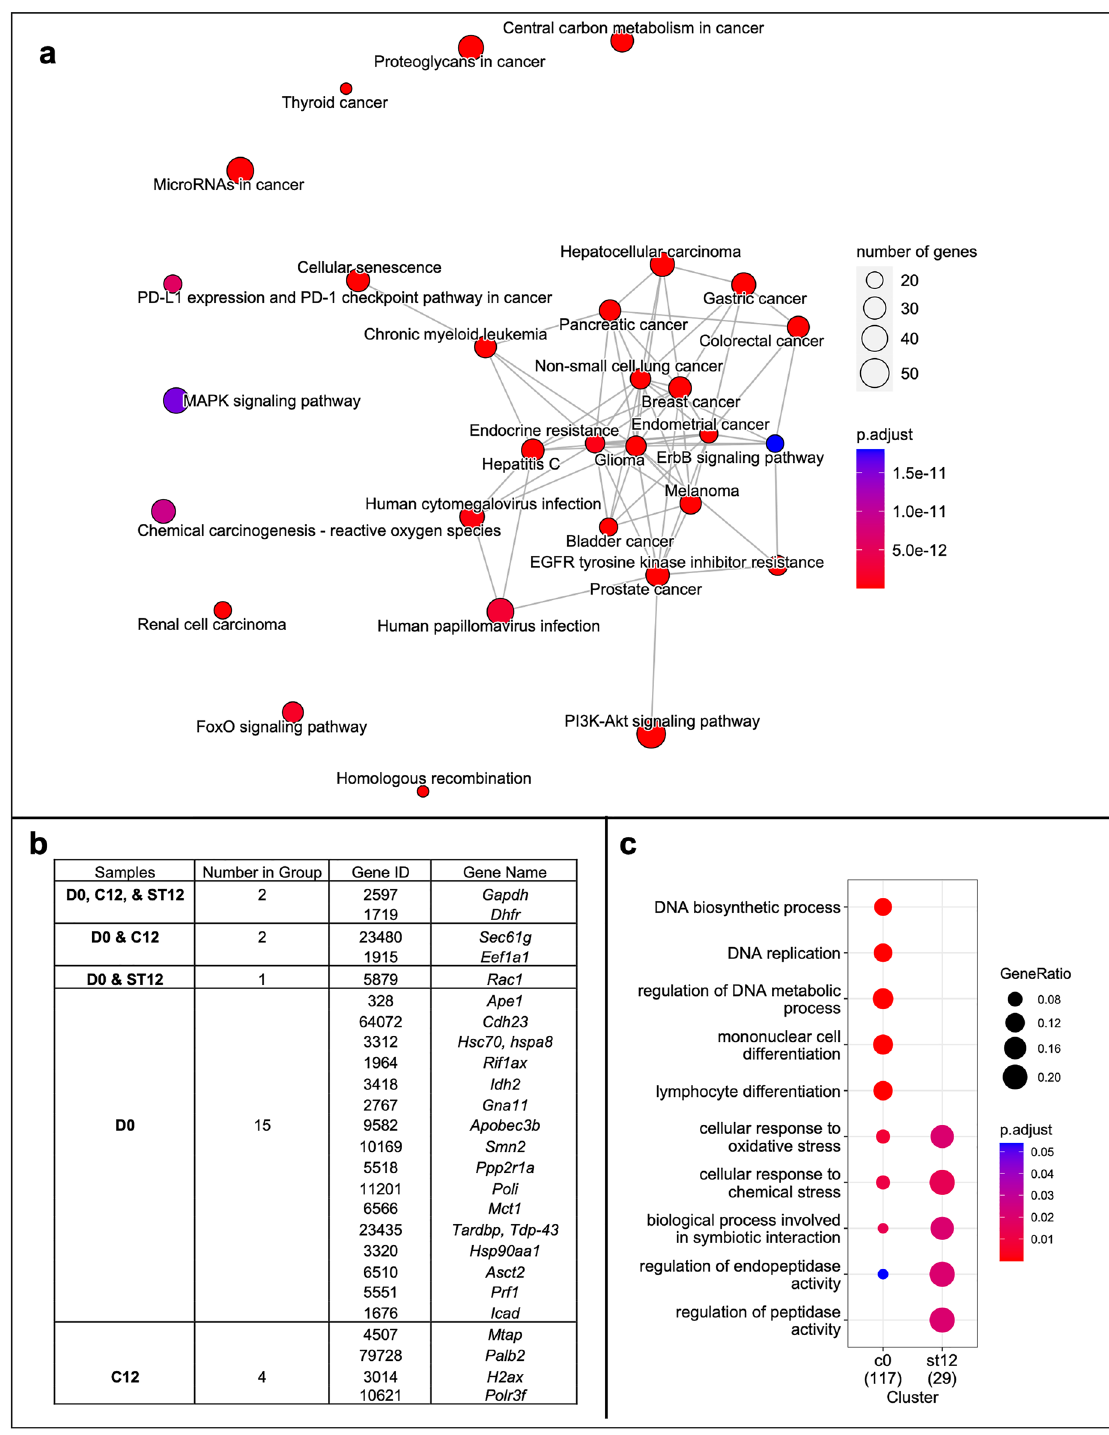
Figure 4. Summary of literature mining results for eccDNA-relevant genes and genome instability linked genes known from literature: KEGG pathway enrichment and CHO culture eccDNA genes. ( a ) Top 30 of the 151 enriched KEGG pathways for the eccDNA-relevant genes texted mined from literature. The node size is proportional to the number of genes found in the pathway, while the node color indicates the pathway’s statistical significance. Pathways with significantly overlapping genes are connected by grey lines. ( b ) EccDNA- relevant genes identified via literature mining that were also found in CHO culture eccDNA sequences from one or more culture conditions: Day 0 (D0), Control Day 12 (C12), Lactate-stressed Day 12 (ST12). ( c ) GO biological process enrichment analysis of genome instability linked genes observed on CHO cell eccDNA. Gene ratio reflects the fraction of genes pertaining to a GO term and the color indicates the statistical